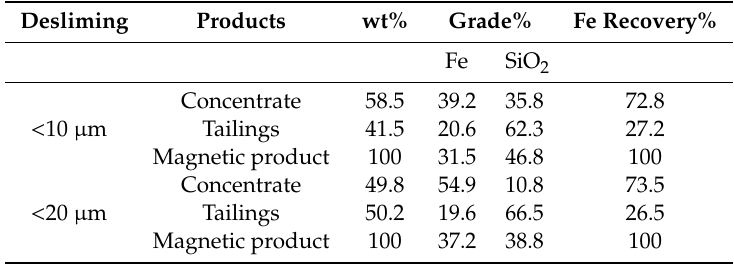
Table 1. Influence of desliming on the reverse cationic flotation of hematite containing tailings of magnetic separation from magnetite ore at the Mikhailovsky plant, Russia